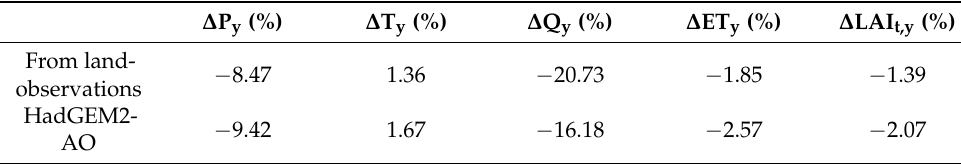
Table 4. Past mean changes (1976 − 2000 with 1951 − 1975) of annual precipitation (P y ), air tempera- ture (T y ), and predicted annual runoff (Q y ), evapotranspiration (ET y ), and tree LAI (LAI t,y ) using observations of the Sardinian meteorological network and the HadGEM2-AO meteorological data as model input. ∆ P ∆ T ∆ Q ∆ ET ∆ LAI y (%) y (%) y (%) y (%) t,y (%) From land- − 8.47 observations HadGEM2-